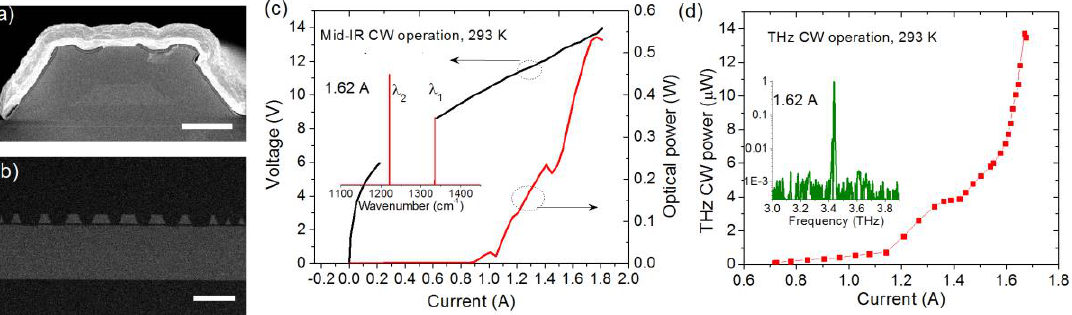
Figure 6. SEM images of a buried ridge ( a ) and buried composite DFB grating waveguide ( b ); the white bars in ( a ) and ( b ) correspond to 10 and 2 µm, respectively; ( c ) P-I-V of a composite DFB THz device at room-temperature CW operation. Inset: CW lasing mid-IR spectrum at 1.62 A; and ( d ) THz CW power as a function of current. Inset: CW THz spectrum at 1.62 A.